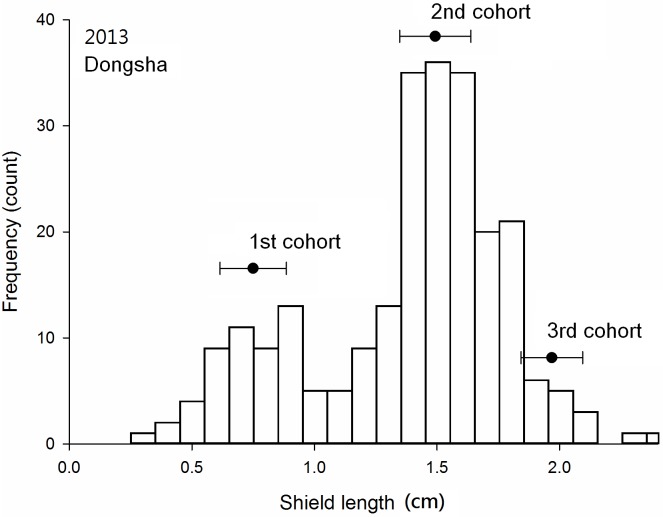
Coenobita rugosus. Size structures and cohort analyses for Dongsha in 2013.Black dots indicate the means and standard deviations of each cohort, as estimated using FISAT II.